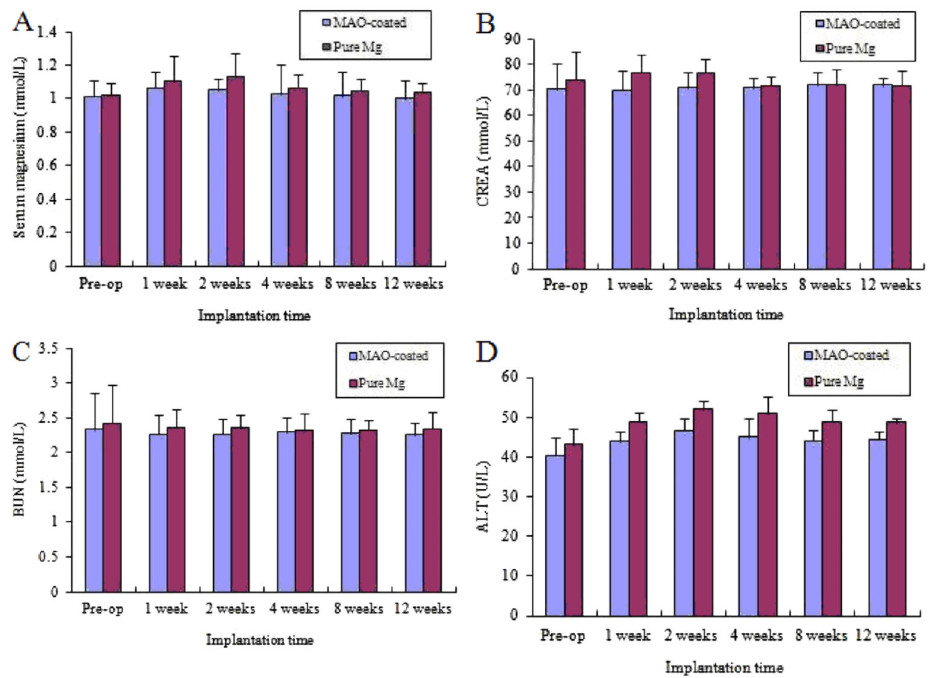
Figure 8. Changes in blood biochemical indicators before and after implantation. A , Serum magnesium; B , creatinine (CREA); C , blood urea nitrogen (BUN); D , alanine aminotransferase (ALT). MAO: micro-arc oxidation.